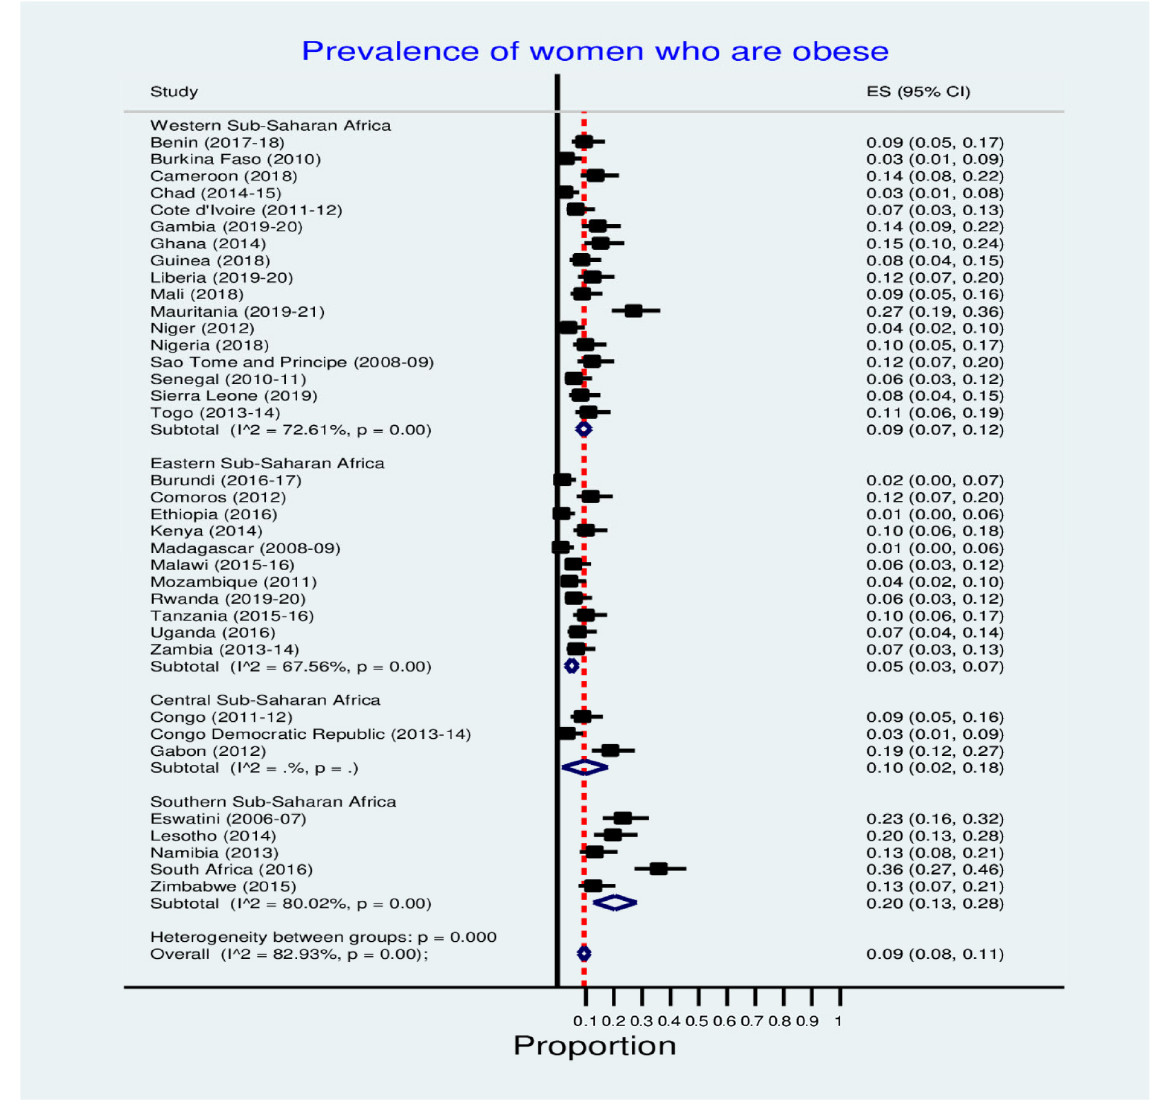
Figure 3. Prevalence of obesity among women in SSA countries. Table 2. Distribution of obesity among SSA countries